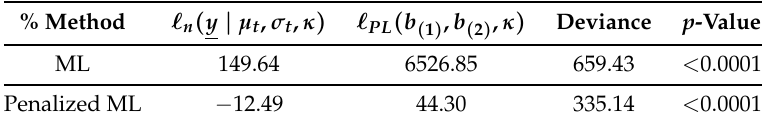
Figure 4. Boxplots of the ultraviolet B radiation (UVB) maxima at seven monitoring stations in the Mexico City metropolitan area. Table 2. Statistical comparison of the adjustment using penalized maximum likelihood against the maximum likelihood